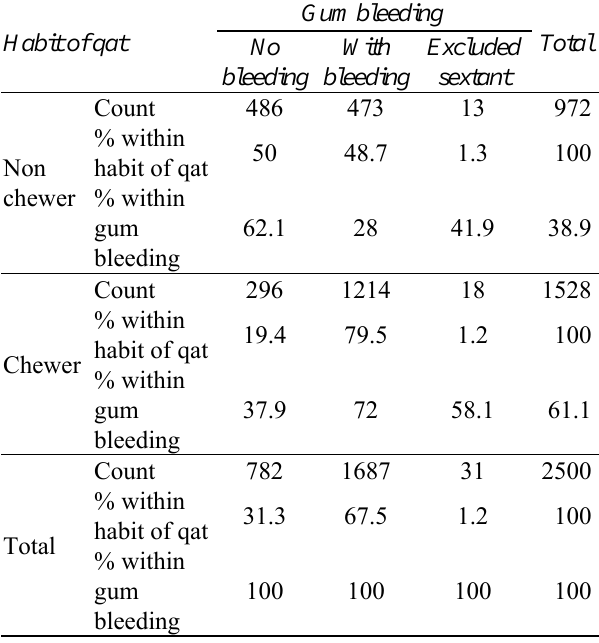
Table 2: Gum bleeding among Yemenis qat chewers and non-chewers